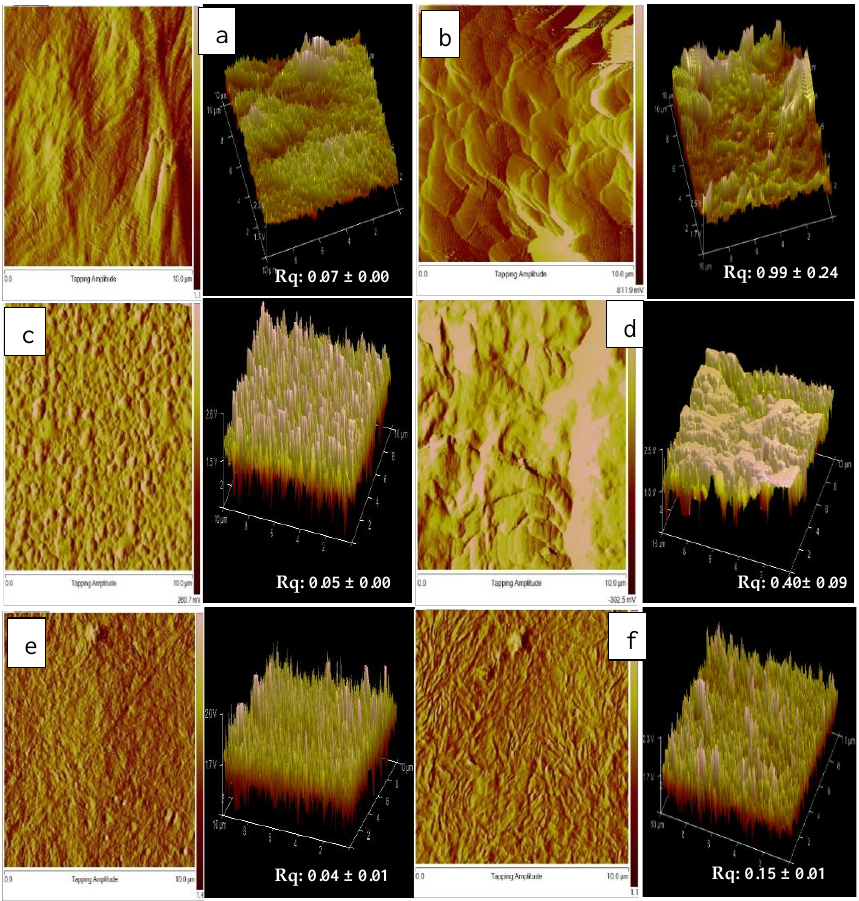
Figure 6. AFM topographic image of ( a ) 0.4g-(P27mo%), ( b ) 0.4g-(P27mol%G10); ( c ) 0.4g-(P50mol%), ( d ) 0.4g-(P50mol%G10); ( e ) 0.4g-(P82mo%) ( f )